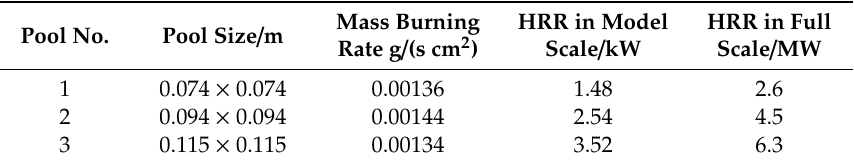
Table 1. Heat release rates